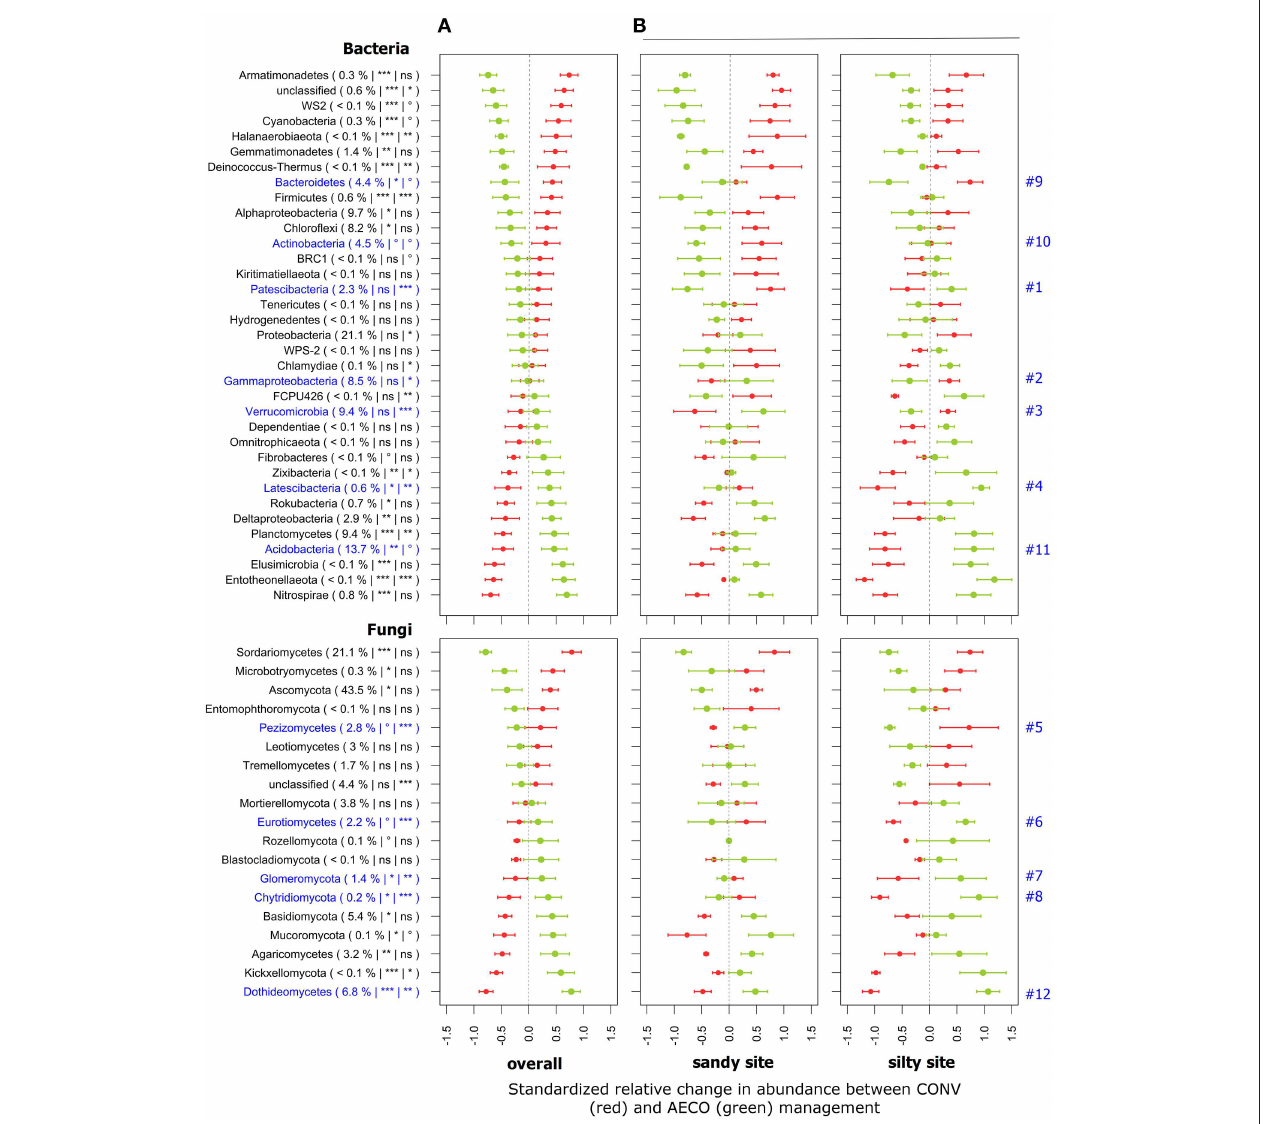
FIGURE 3 | Standardized relative changes in abundance of higher-order taxonomic groups between conventional (red) and agroecological (green) management across all textural sites (A) and separately for each individual textural site (B) . Proteobacteria (Alpha-, Gamma-, Delta-proteobacteria), Ascomycota and Basidiomycota were additionally split into the major classes. Data were z -transformed, representing values greater or smaller than the average across all samples. The standardized relative mean and standard deviations are provided for each taxon. The relative abundance as well as the significance of the PERMANOVA test is indicated in brackets: the first argument represents the relative abundance, the second the significance of agricultural management, and the third the significance of the interaction between management and textural site; *** p < 0.001, ** p < 0.01, * p < 0.05, ◦ p < 0.1 and ns, not significant. The p -values were corrected for multiple comparisons using the Benjamini-Hochberg procedure. Taxa labeled in blue have revealed a contrasting response to agricultural management across the textural sites as detailed in the main